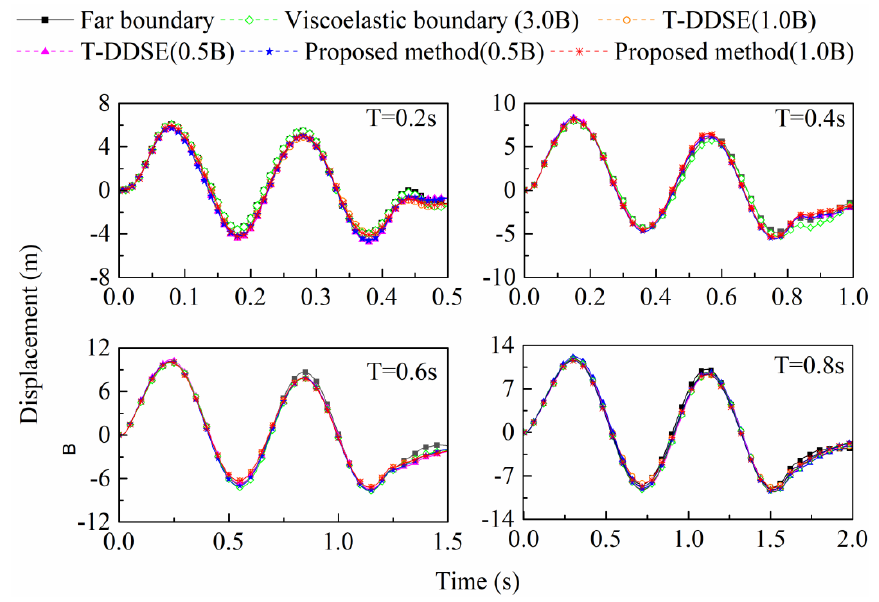
Figure 3. Comparison of displacement response at the central point of the interface.